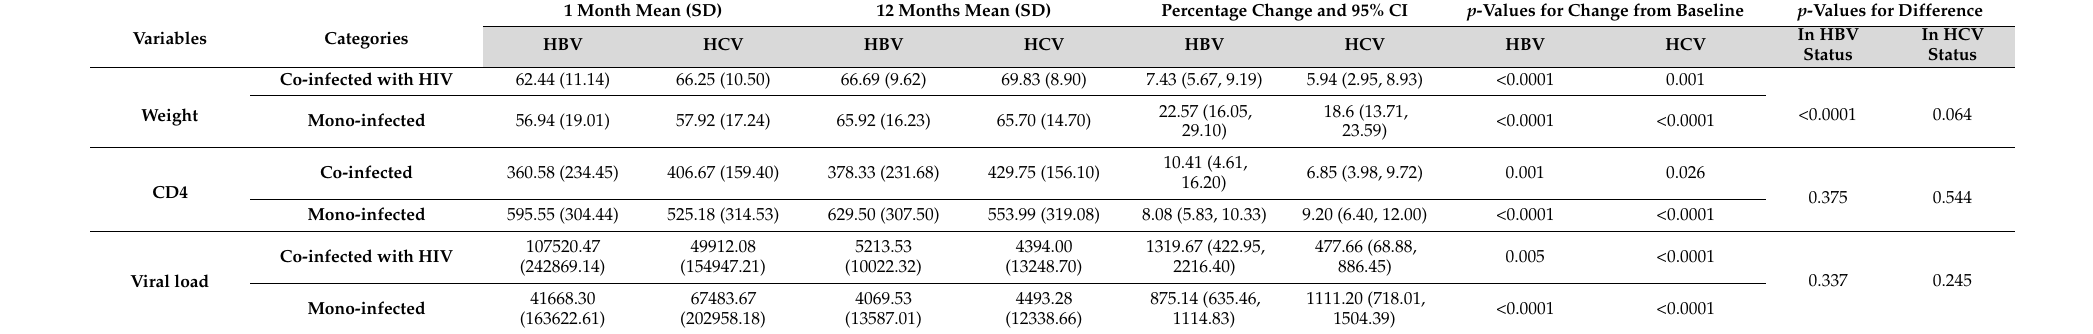
Table 3. Mean immune response measurements and percentage change between 1 and 12 months in co-infected and mono-infected